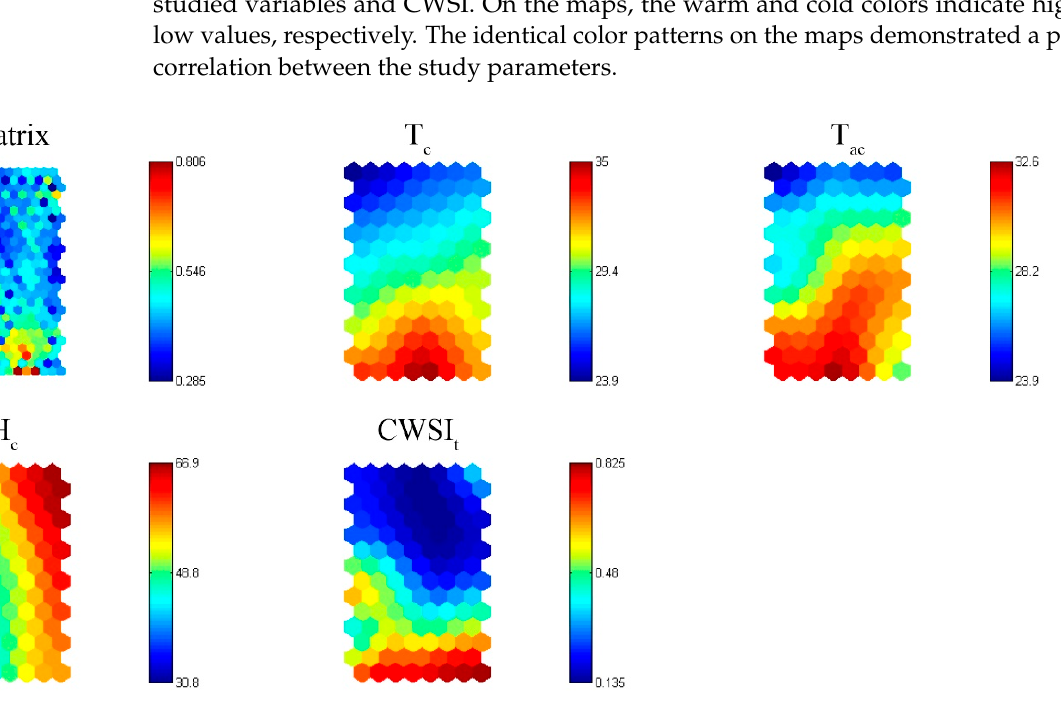
Figure 5. Component planes of the variables (T c —canopy temperature, T ac —air temperature above the canopy, RH c —relative humidity above the canopy) for crop water stress index, CWSI t.